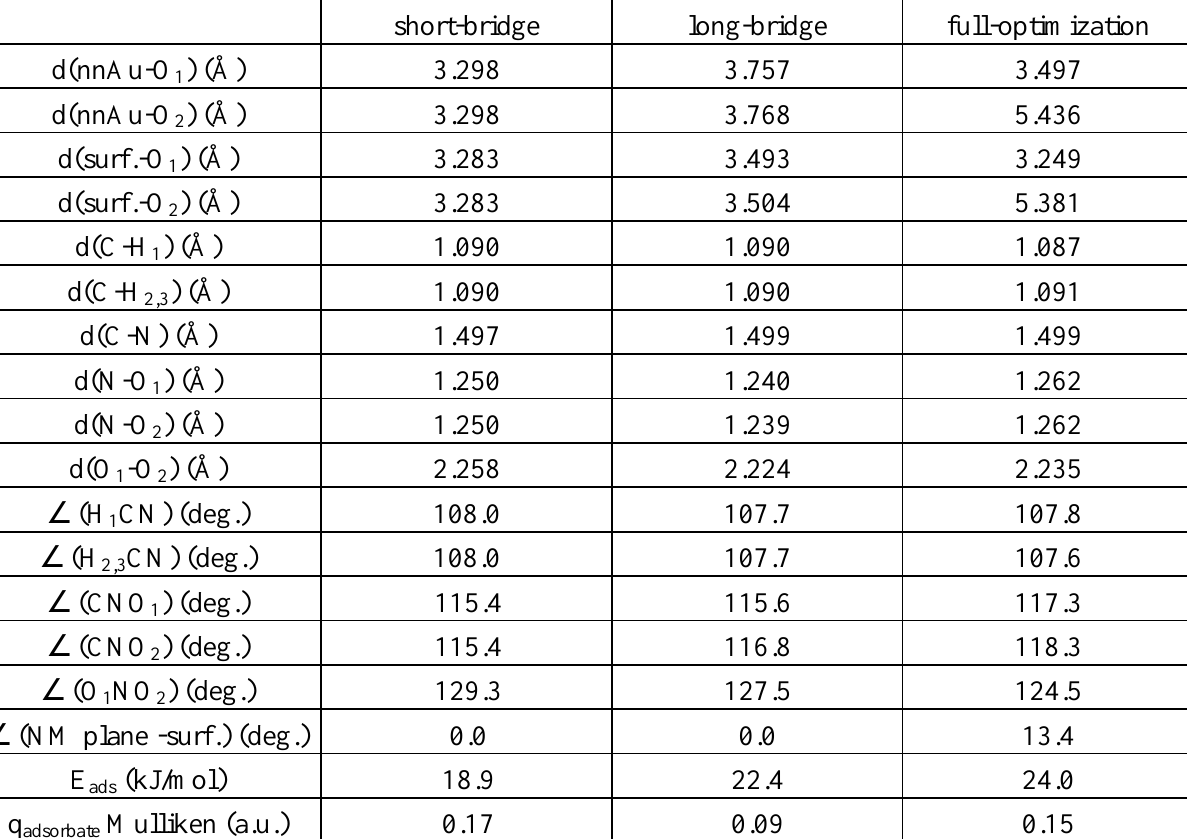
Table 4. Calculated geometrical parameters for nitromethane adsorbed on the Au(111) surface.